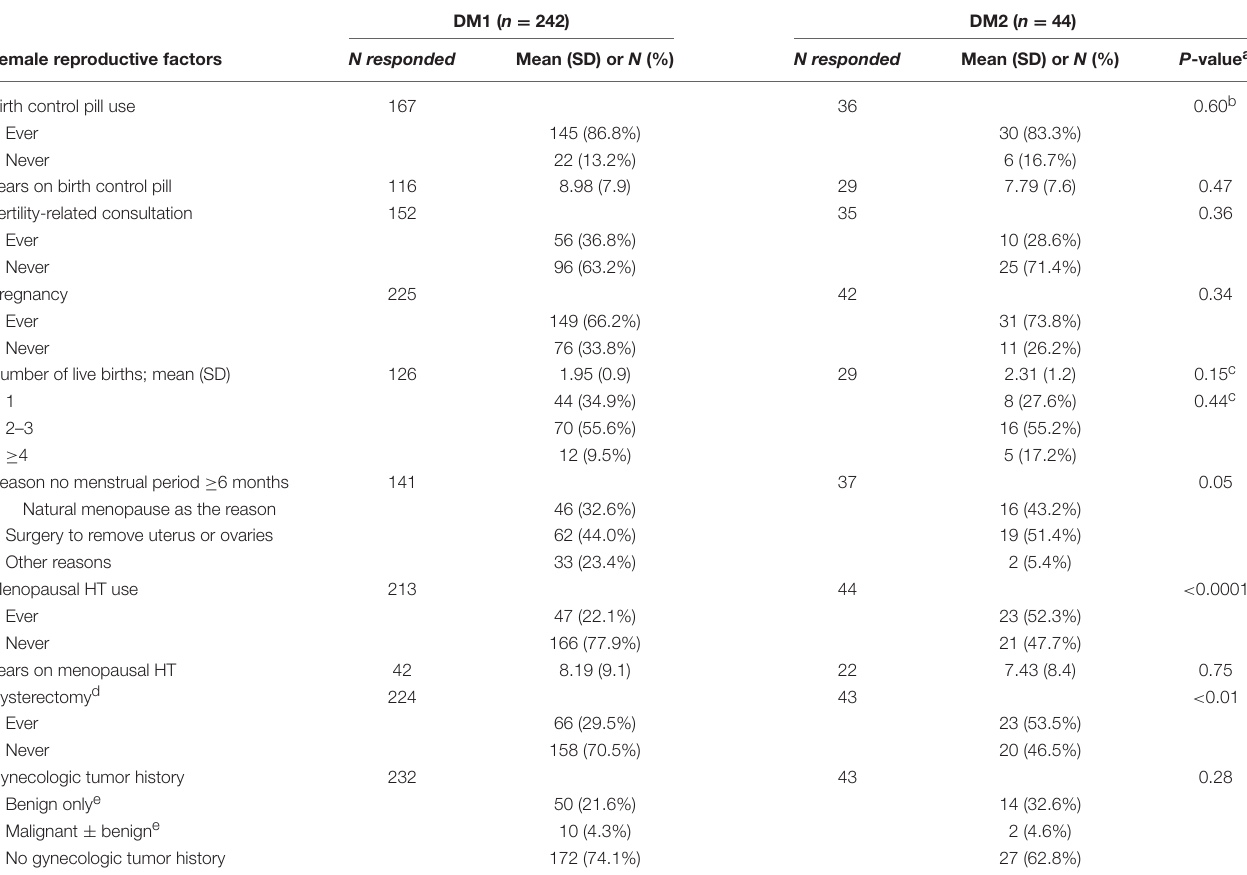
TABLE 2 | Selected female reproductive cancer risk factors among women with DM by disease